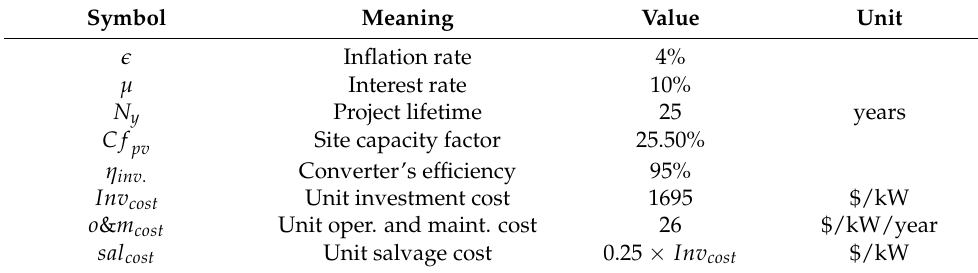
Table 1. Cost and technical parameters for solar PV system